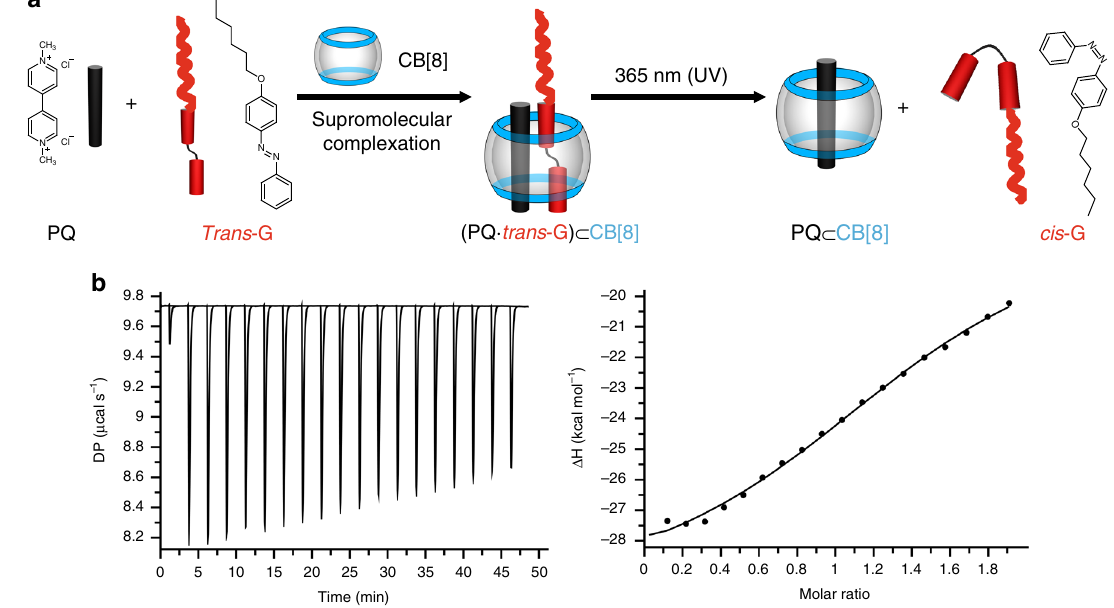
Fig. 1 Complexation of CB[8], PQ, and trans -G. a Schematic illustration of CB[8]-mediated complexation with PQ as the fi rst guest and trans -G as the second guest, as well as the photo-driven, reversible transition between complexation with the trans -G isomer and decomplexation with the cis -G isomer. b ITC thermograms: trans -G (0.04 mM) titrated with PQ ⊂ CB[8] (0.4